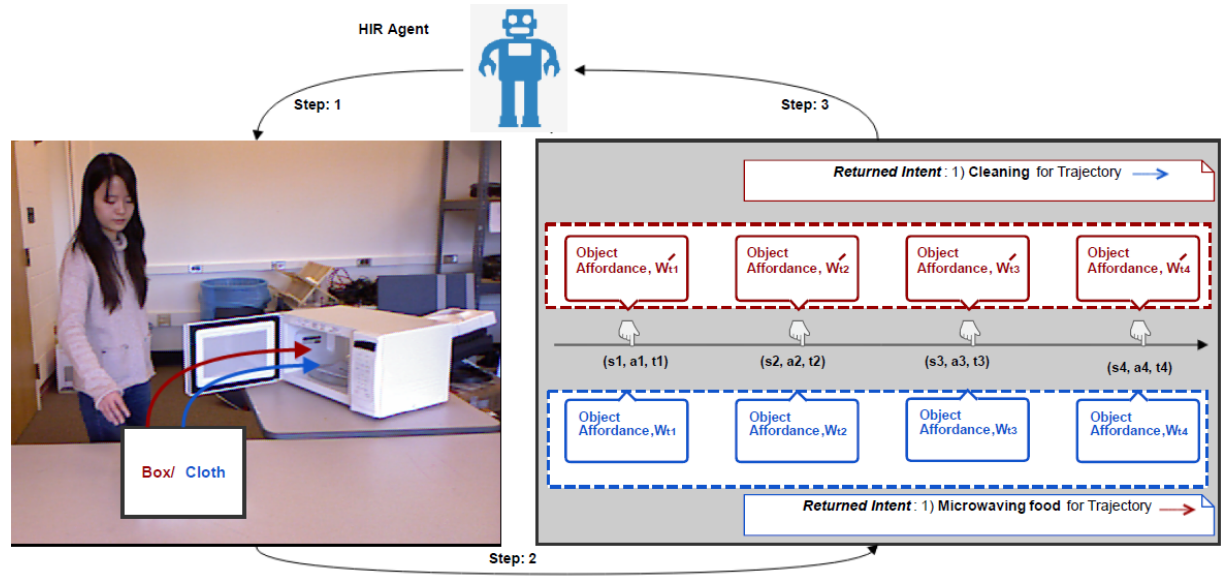
Figure 2: Human Intent Recognizer (HIR) (video frame source: CAD-120 [6]).